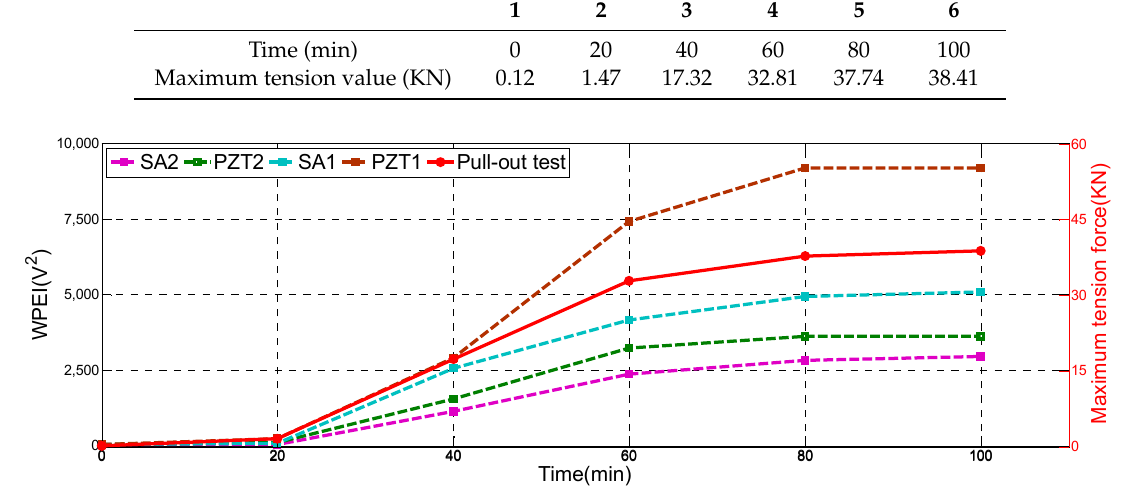
Figure 14. The WPEI and maximum tension value